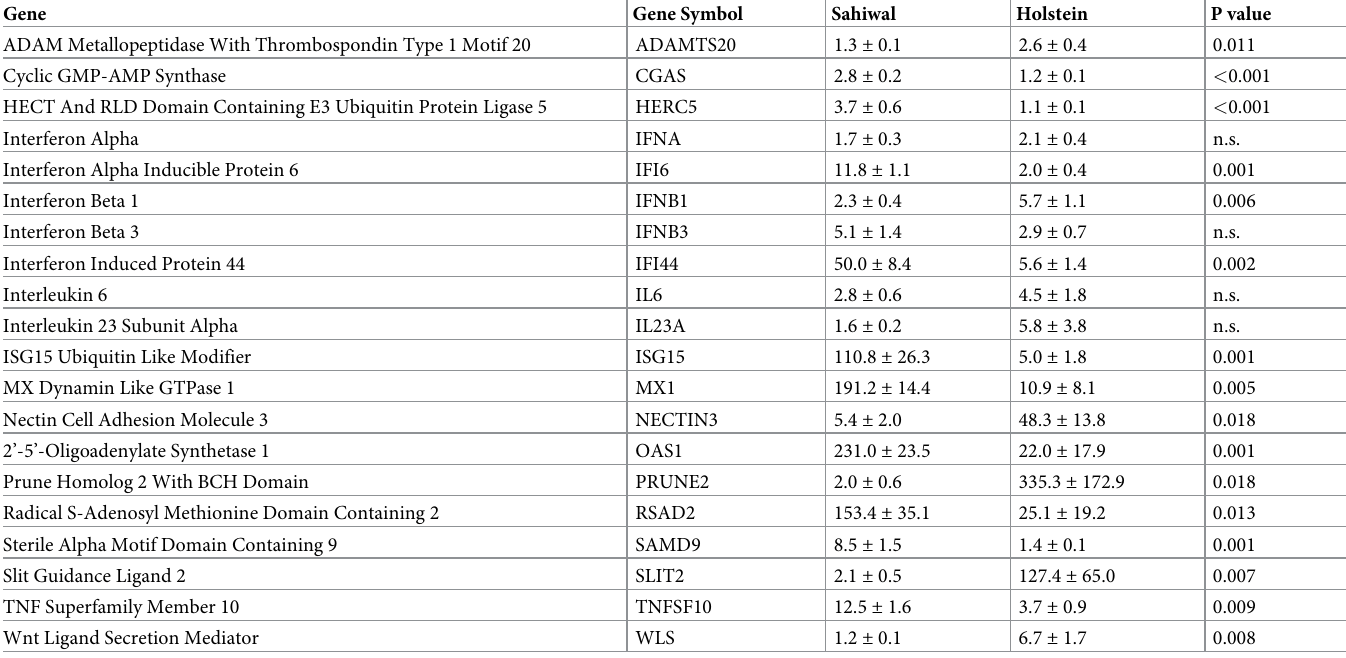
Table 4. qRT-PCR validation of differential expression of a subset of H/S-DE genes. Gene Gene